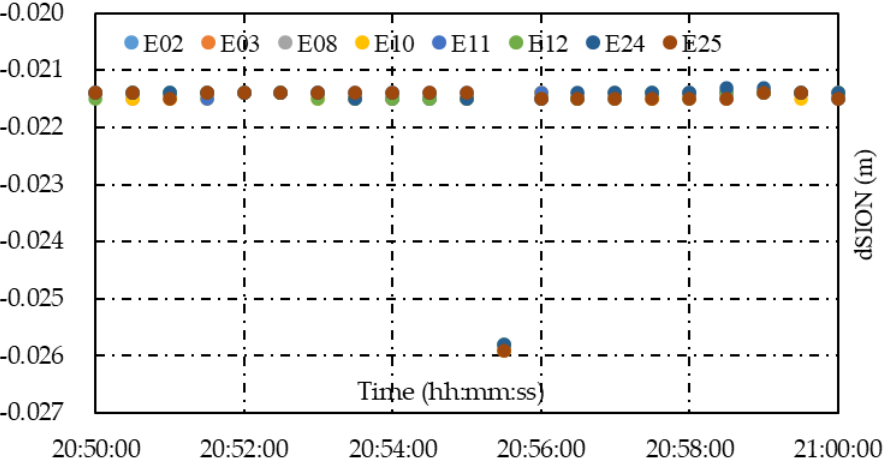
Figure 9. dSIONs between method B and A from static PPP with various satellites.